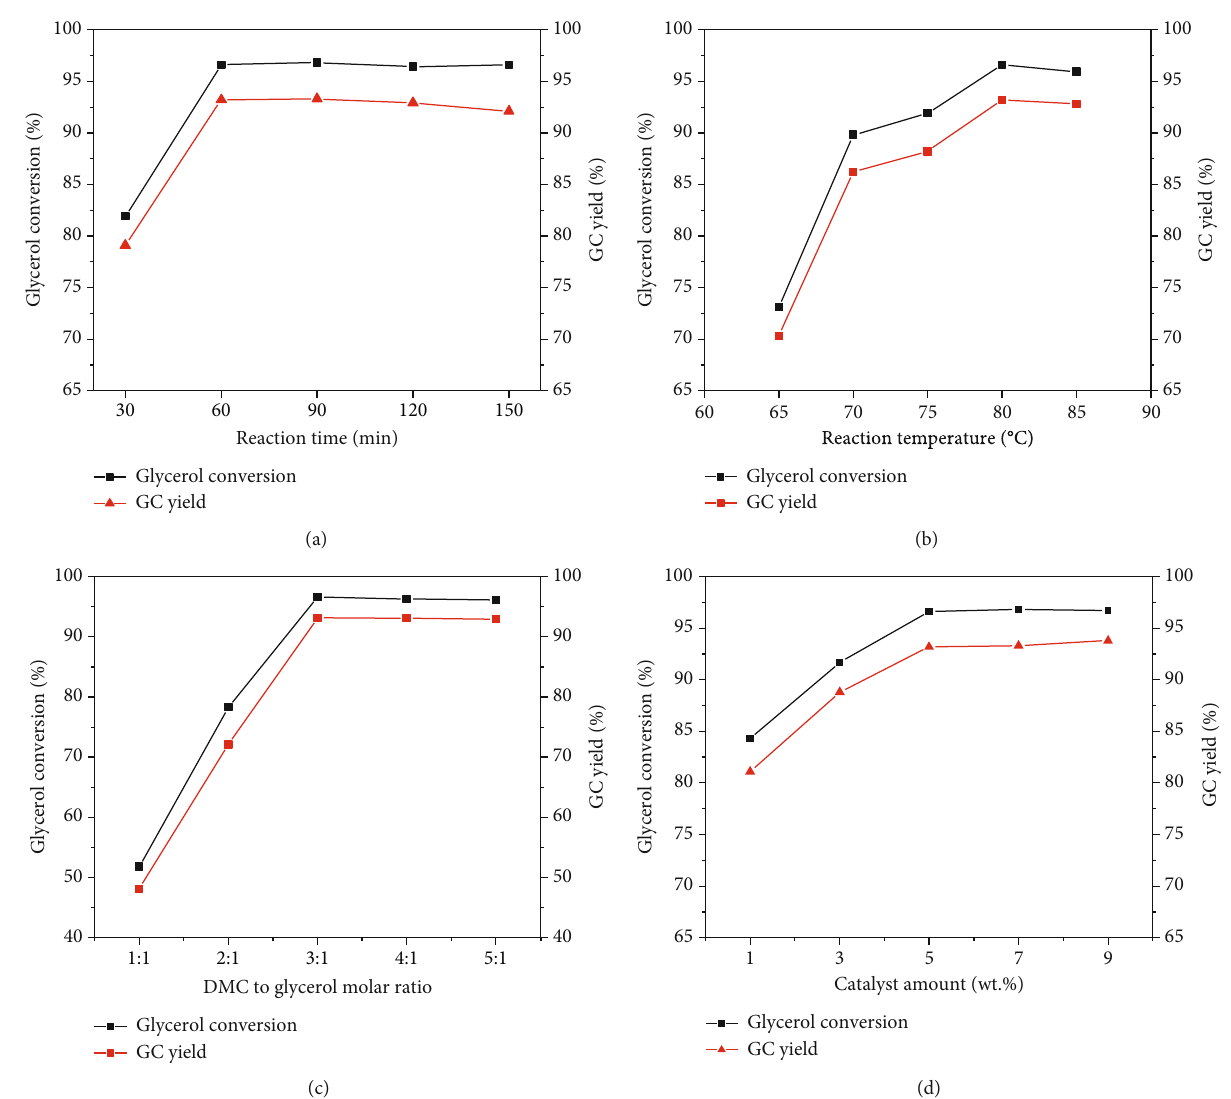
Figure 6: E ff ect of reaction condition on the synthesis of GC. (a) E ff ect of reaction time. (b) E ff ect of reaction temperature. (c) E ff ect of DMC to glycerol molar ratio. (d) E ff ect of Catalyst amount. The detailed reaction condition was listed in Table